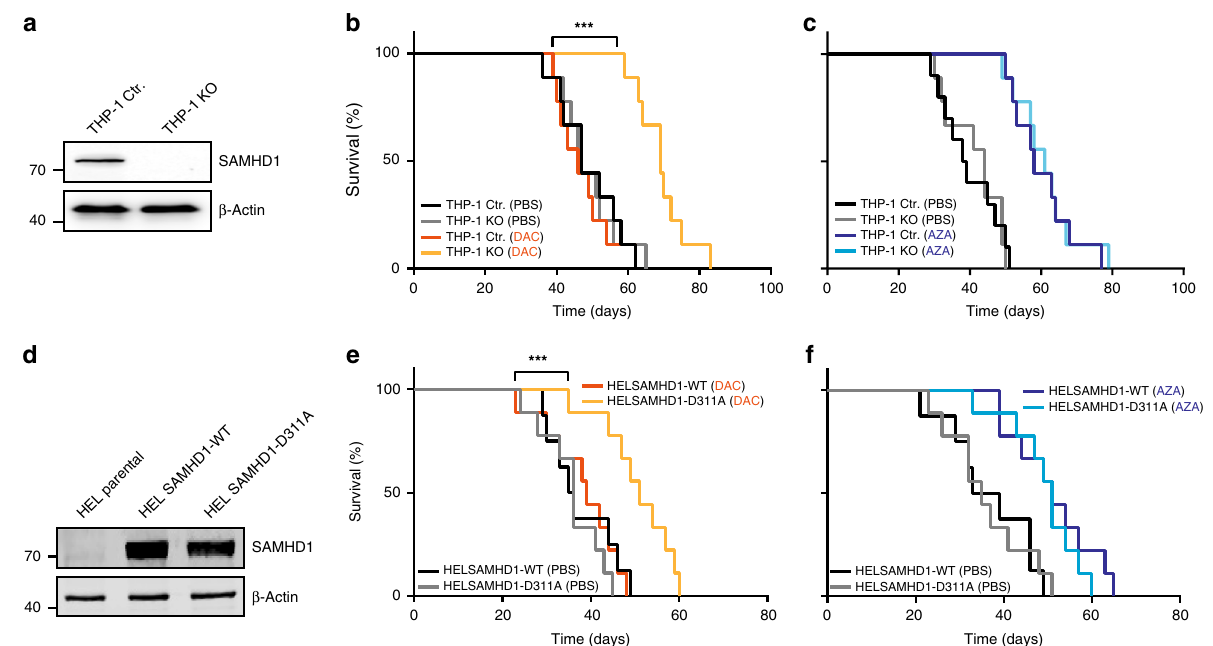
Fig. 5 SAMHD1 expression in xenotransplanted AMLs predicts the response to DAC. a , d SAMHD1 protein expression in transplanted cell lines determined by immunoblotting. b , c , e , f Kaplan – Meier survival analyses of NSG mice transplanted with either ( b , c ) THP-1 control or THP-1 KO cells or ( e , f ) HEL cells expressing SAMHD1-wild-type (WT) or the D311A mutant. b , e DAC was administered i.p. (0.4 mg/kg twice per week), c , f AZA was administered i.v. (2.8 mg/kg 5× per week); PBS (control treatment). P -values are from the Mantel Cox (Logrank) test. *** P <